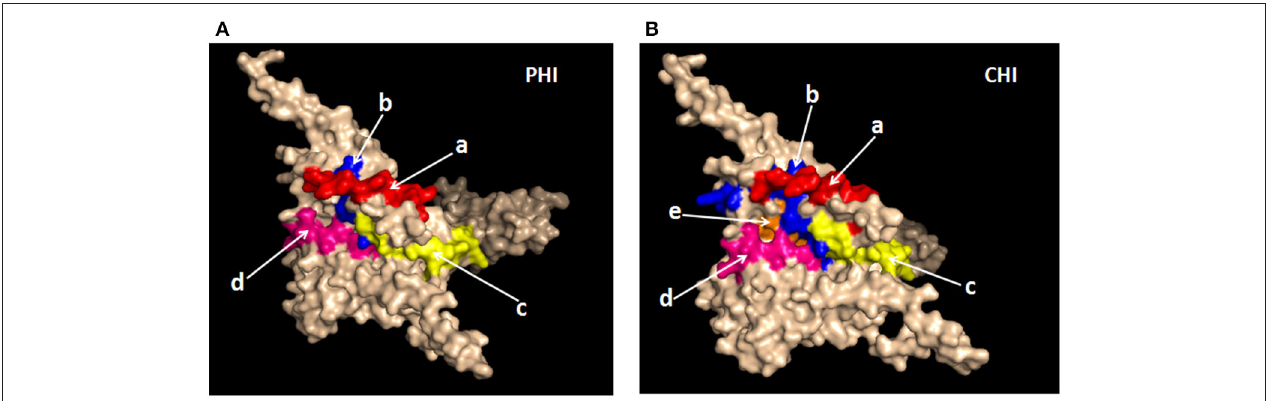
FIGURE 6 | Spatial positions of relatively conserved Env epitopes recognized by ADCC responses in PHI and CHI. (A) Simulated spatial structures of the relatively conserved Env epitopes in PHI. a: HNVWATYACVPTDPNPQE (red); b: QCTHGIKPVVSTQLLLNG (blue); c: TSVIKQACPKISFDPIPI (yellow); d: VVSTQLLLNGSLAEEEII (pink). (B) Simulated spatial structures of the relatively conserved Env epitopes in CHI. a: HNVWATYACVPTDPNPQE (red); b: PCKNVSSVQCTHGIKPVV (blue); c: TSVIKQACPKISFDPIPI (yellow); d: VVSTQLLLNGSLAEEEII (pink); e: RPGGGNIKDNWRSELYKY